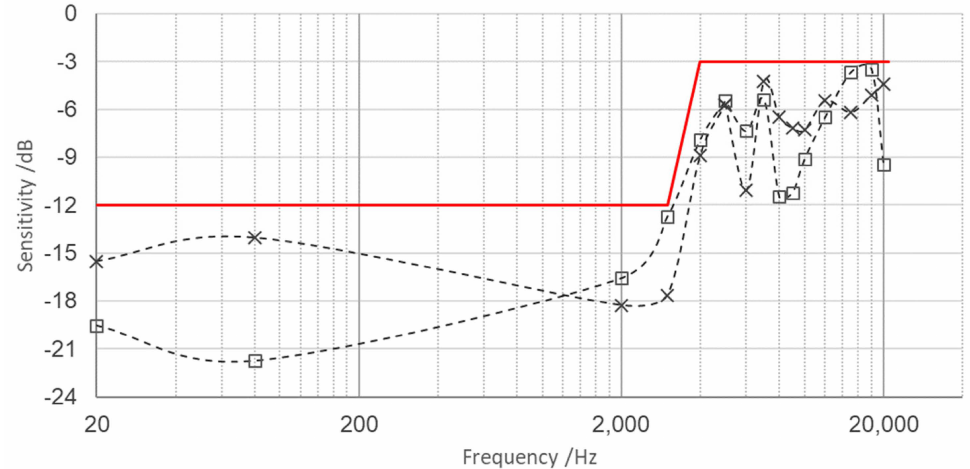
Figure 9. Full scale range of the relative amplitude of transverse sensitivity (grey dotted lines, square X axis, cross Y axis) on the horizontal plane with respect to the sensitivity measured along the vertical axis, which is the direction of reference acceleration (parallel to g ).